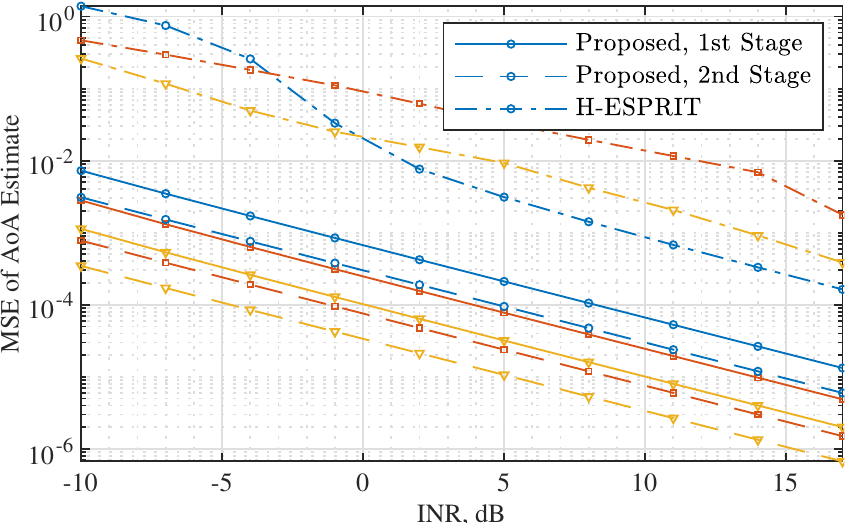
Figure 6. MSE of the AoA estimates versus INR (= σ 2 square, and triangle markers are for N = 8, 16, and 24, respectively.